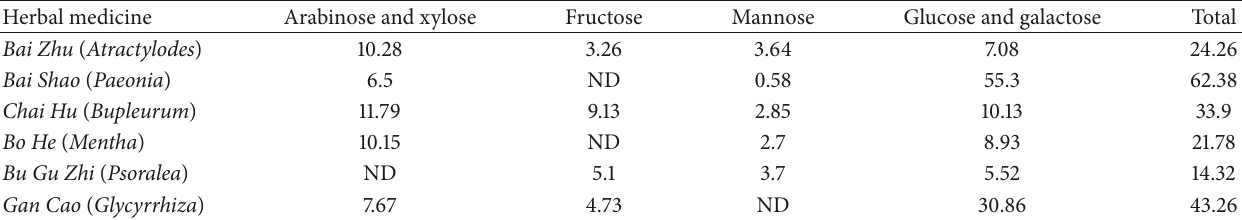
Table 4: Total sugar (% of dry matter) in form of monosaccharide in the samples determined using HPLC. Herbal medicine Arabinose and xylose